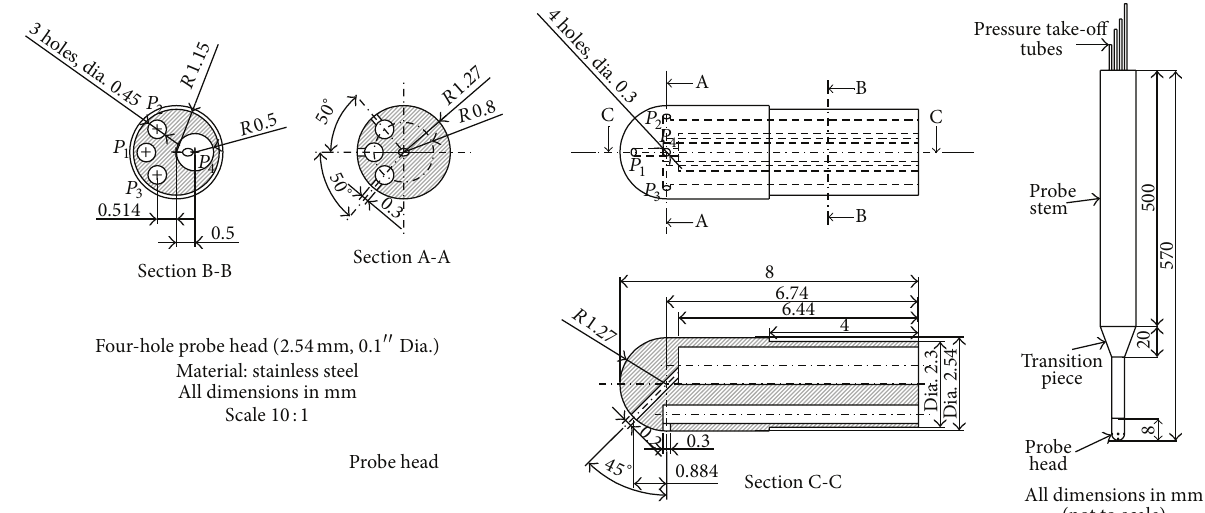
Figure 1: Orthogonal views of the four-hole pressure probe head and schematic of the probe.